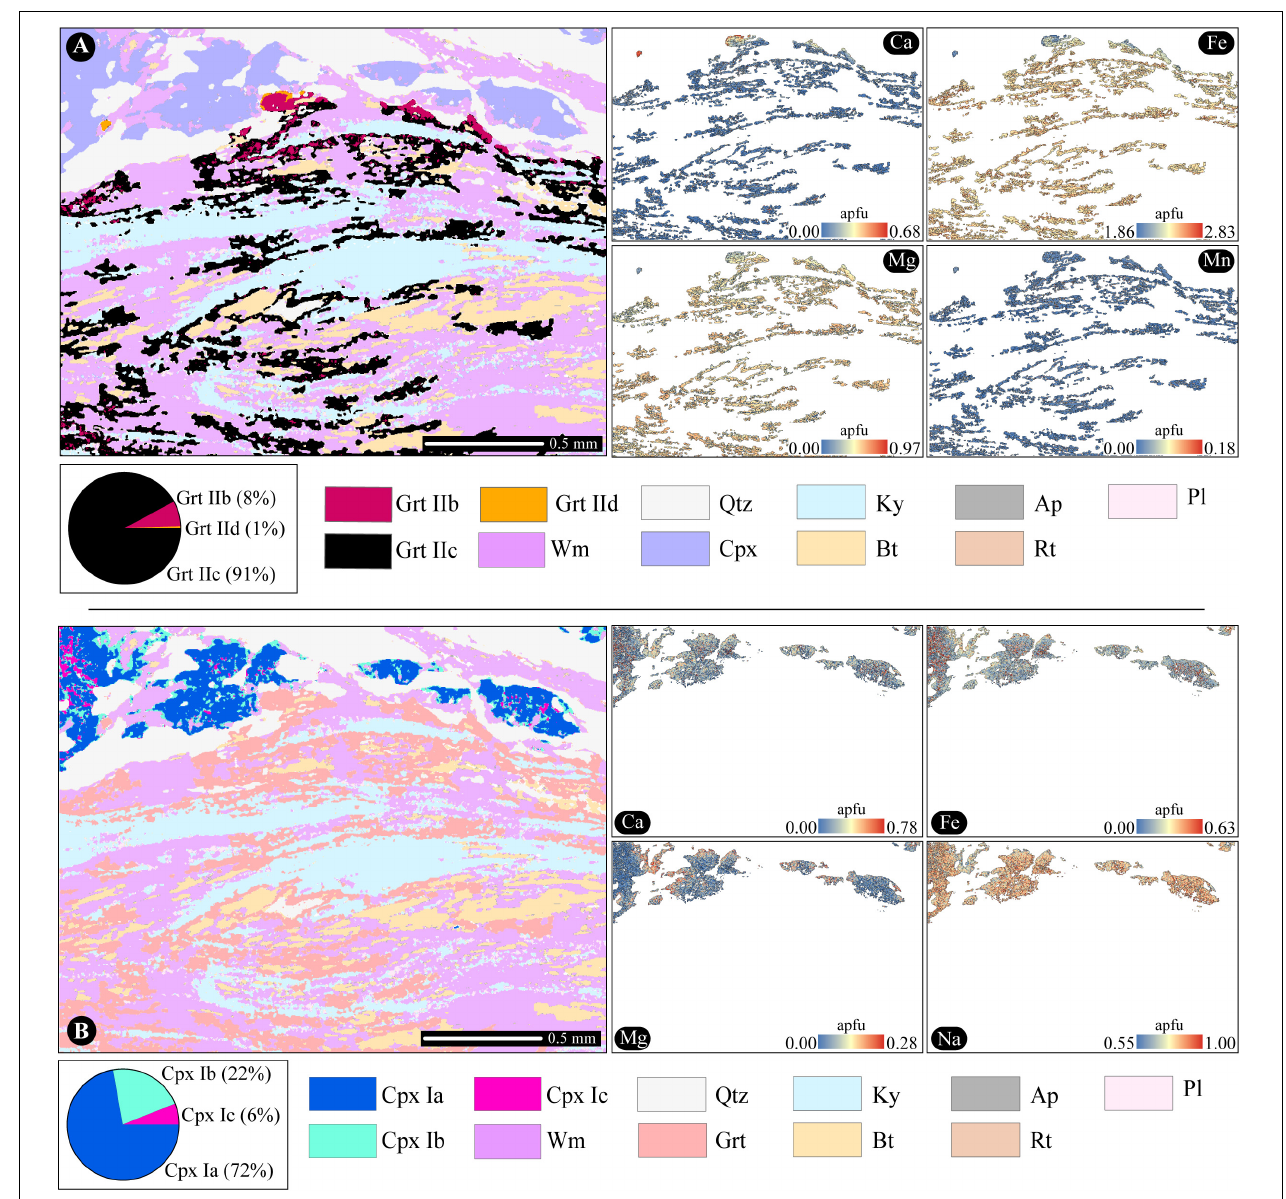
FIGURE 8 | Results of second cycle of Q-XRMA procedure for pre-alpine Sill microdomain. (A) Grt sub-phases classification and their modal percentage. Calibration maps of Ca, Fe, Mg, and Mn contents in Grt. (B) Cpx sub-phases classification and their modal percentage. Calibration maps of Ca, Fe, Mg, and Na contents in Cpx.